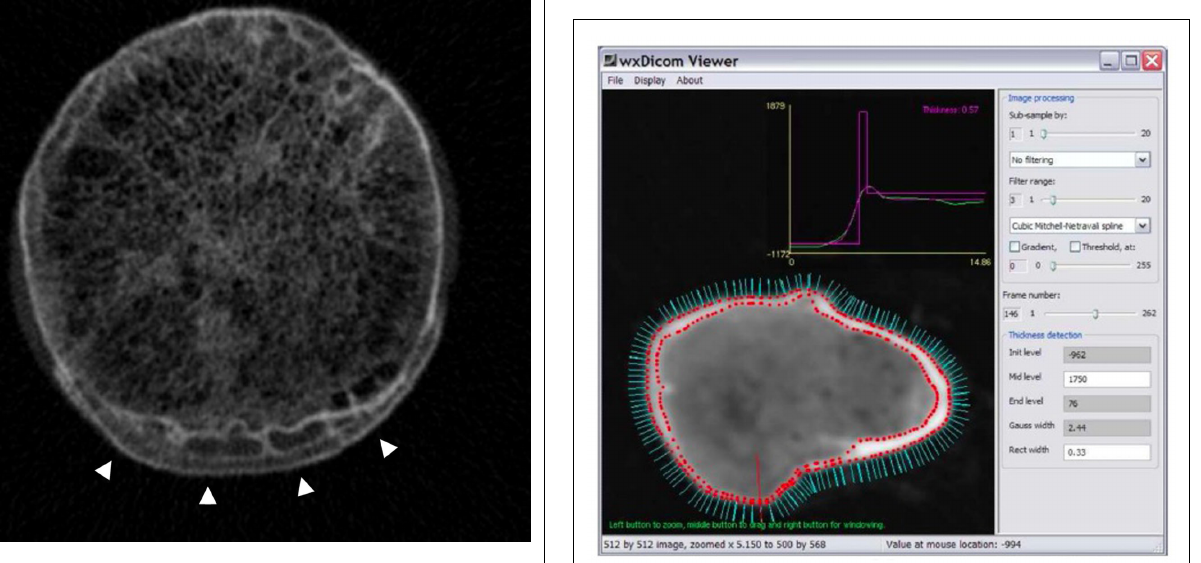
FIGURE 8 | Surface normals (cyan) around the neck of the right femur (imaged with CT), each of which can be used as a point for cortical thickness measurement; a single measurement is made at the point of the red line and displayed as the magenta peak in the graph above (0.57mm). Image courtesy of Dr. GrahamTreece, Department of Engineering, University of Cambridge.